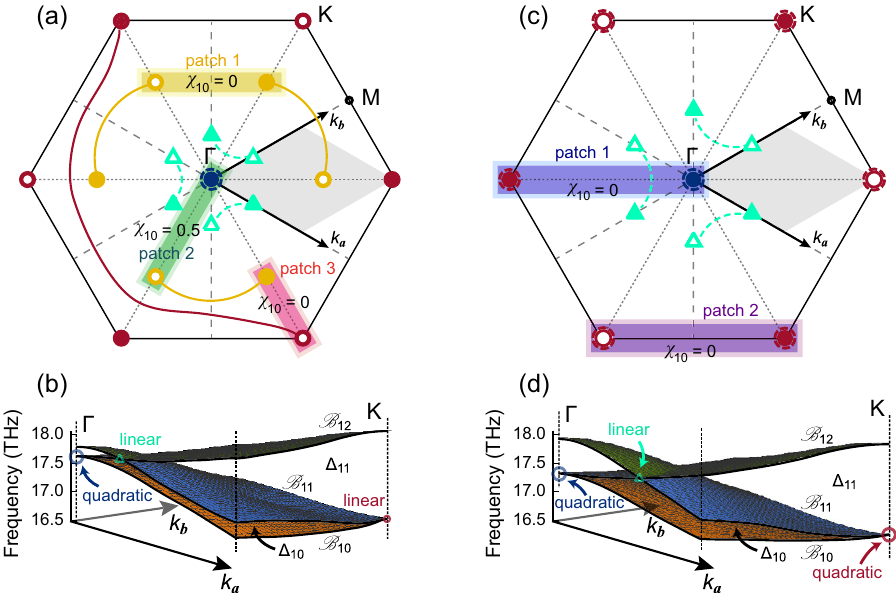
Fig. 3 Euler class calculations. a Patches in the Brillouin zone and their corresponding Euler class for 7% strained silicate under an electric fi eld of 1.0 eV/ Å . The Euler class χ B B 10 is calculated from the phonon eigenvectors of 10 and 11 within the patches. The resultant patch Euler class in the yellow (patch 1), green (patch 2) and magenta (patch 3) areas are 0, 0.5 and 0, respectively. The large blue circle with dashed boundary at Γ is a quadratic node with the patch Euler class of 1. b 3D band structures in the grey areas of ( a ), with two linear nodes — one (cyan triangle) in Δ 11 along Γ -M and one (dark red circle) in Δ Δ Γ . These dispersions root in the stability of Euler class, meaning that a stable double node 10 at K, as well as a quadratic node (blue circle) in 10 at produces a quadratic dispersion. c Patches in the Brillouin zone to calculate the Euler class for 7% strained silicate under an electric fi eld of 1.8 eV/ Å . The patch Euler class in the blue (patch 1) and purple (patch 2) patches are both 0. The large blue circle with dashed boundary at Γ and the large dark red circles with dashed boundary at K are quadratic nodes with the patch Euler class of 1. d 3D band structures in the grey areas of ( c ), with one linear node (cyan triangle) in Δ 11 along Γ – M and two quadratic nodes in Δ 10 at Γ (blue circle) and K (dark red